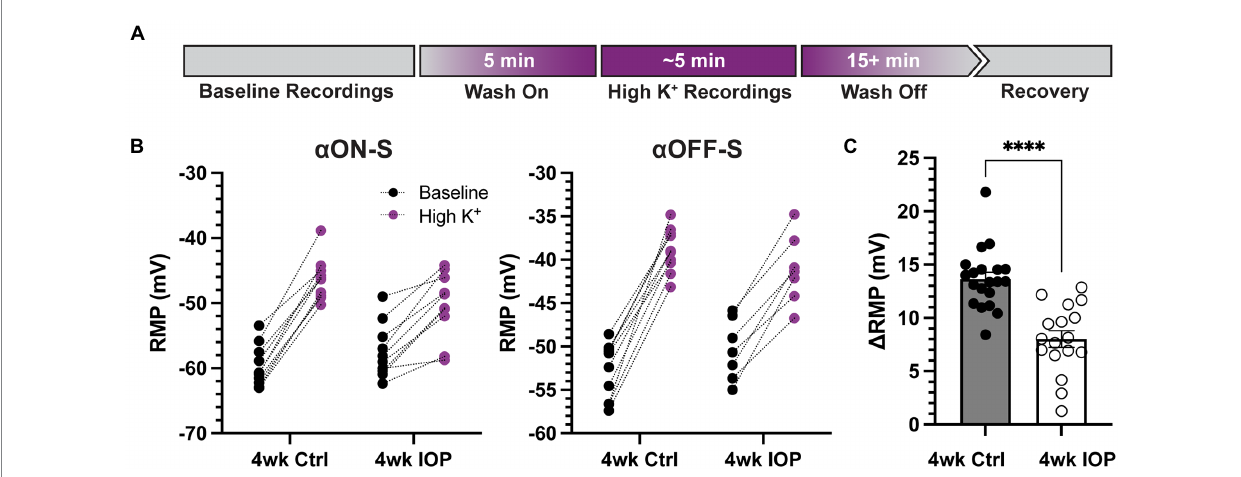
FIGURE 3 Elevated IOP reduces the influence of extracellular potassium on RGC depolarization. (A) Timeline illustrating the design of acutely elevated extracellular potassium (High K + ) experiments. Following baseline recordings, extracellular medium with an extra 5 mM KCl is washed on for 5 min until membrane potentials stabilized. High K + recordings are done, and then high K + is washed off with regular extracellular medium until full recovery of membrane potential and spontaneous spiking, at least 15 min. (B) Resting membrane potentials (RMPs) for α ON-S and α OFF-S cells in both experimental groups before and after high K + wash on. There is a significant interaction effect between K + and IOP for both α ON-S ( p = 0.0002; 2-way repeated measures ANOVA) and α OFF-S (0.0063) cells. (C) The change in RMP following high K + wash on for each cell, separated by experimental group. Cells exposed to 4wk IOP elevation are significantly less depolarized by high K + ( p = 0.00000091, Mann–Whitney test). Error bars: ± standard error of the mean. **** p < 0.0001.